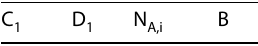
Table 1 Values for the grinding tool specific constant B